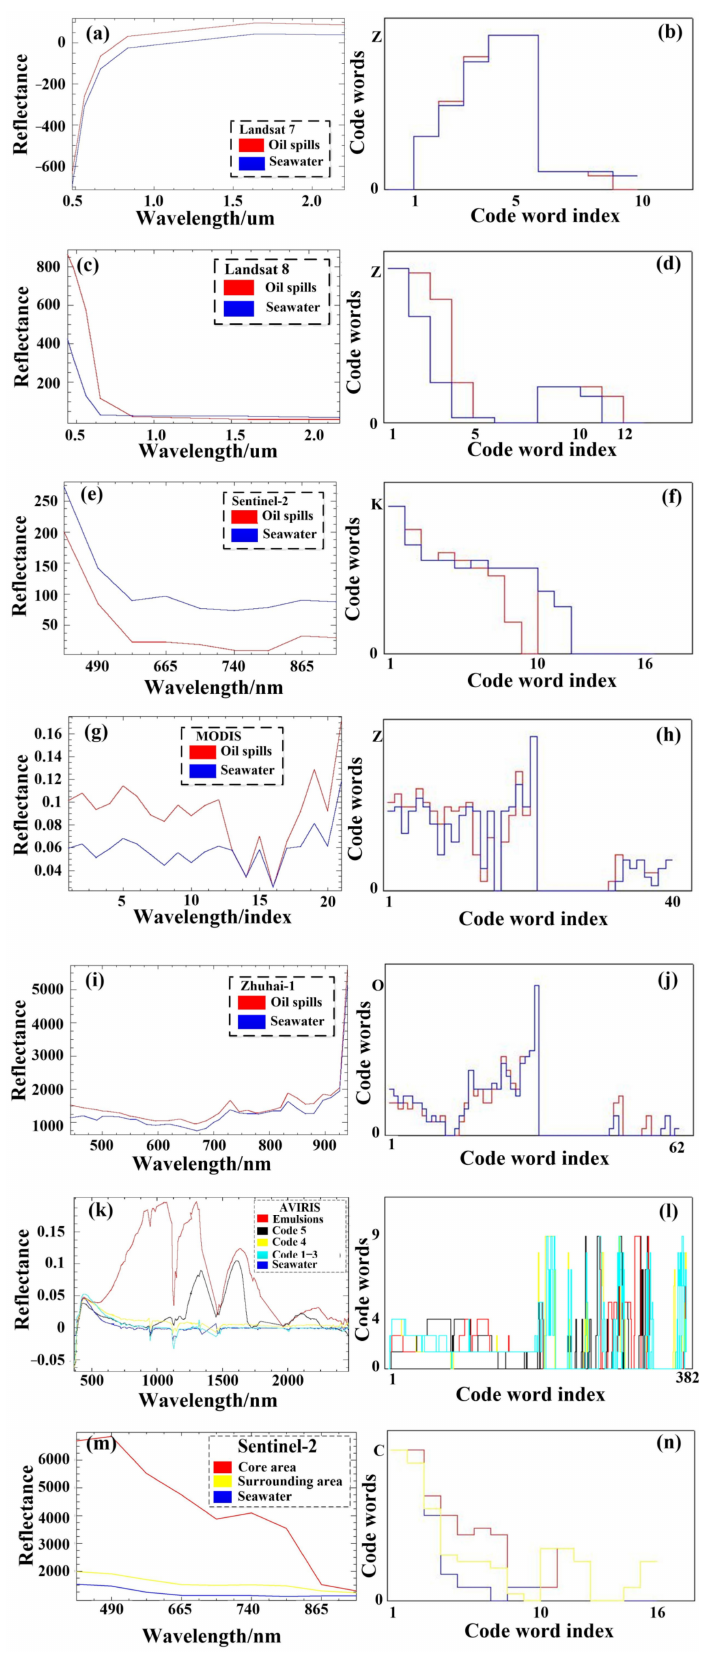
Figure 14. The spectra of oil-gas leakage objects and their spectral encoding results by the MSE method with SSI. Subfigures ( a , c , e , g , i , k , m ) were the original spectra of oil-gas leakages in